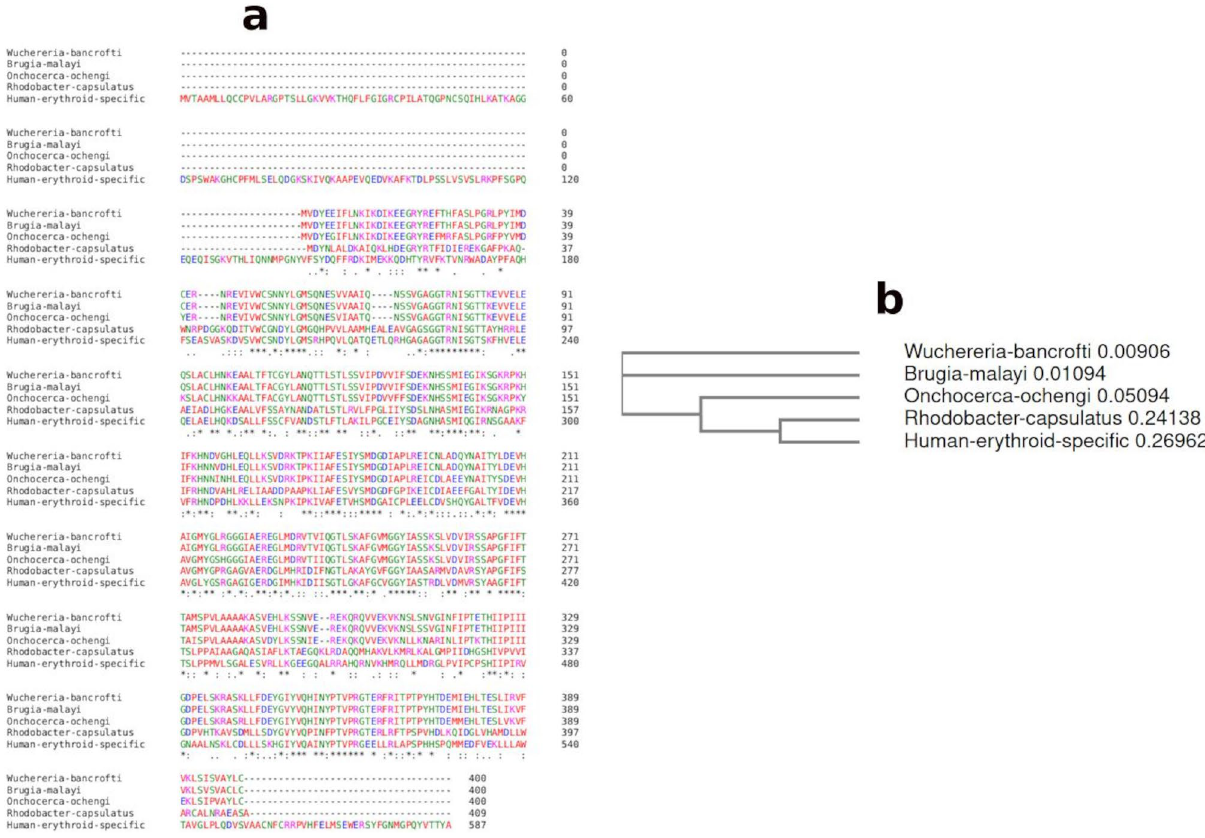
Figure 3. Evolutionary relatedness of w ALAS in nematodes and other species. ( a ) Multiple sequence alignment of w ALAS of W. bancrofti endosymbiont, B. malayi endosymbiont, R. capsulatus and human. ( b ) Simple phylogram depicting the evolutionary relatedness of the w ALAS